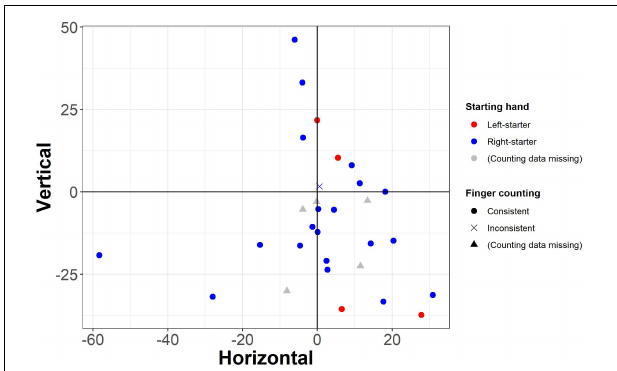
FIGURE 5 | Individual slopes resulting from the horizontal and vertical analyses (see axis labels). Each data point represents one participant. Circles: consistent finger counters (from thumb to pinkie with both hands); cross: inconsistent finger counter (from index finger to pinkie with the starting hand). Red: left-starters; blue: right-starters; gray triangles: missing counting